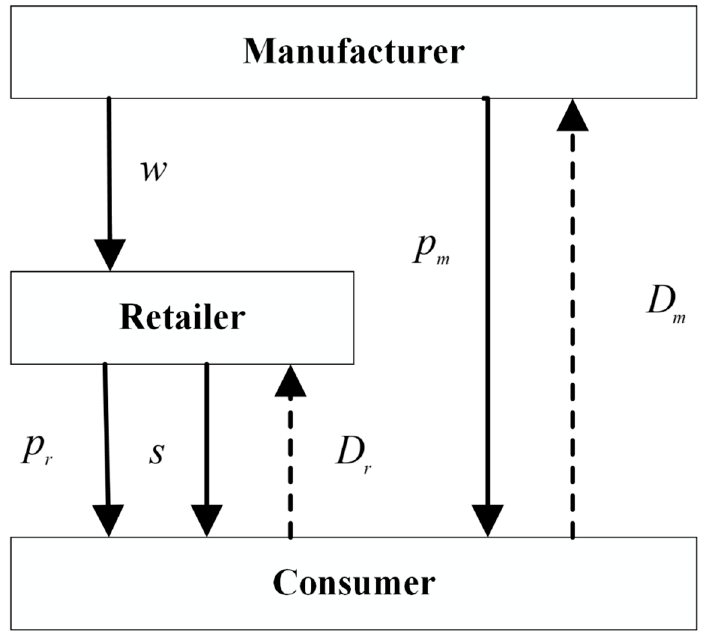
Figure 1. A dual-channel supply chain.